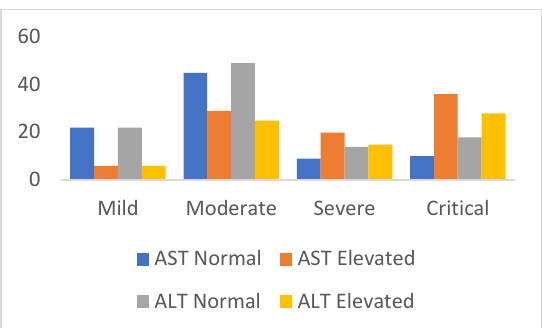
Figure 1. Transaminase level and severity of COVID-19